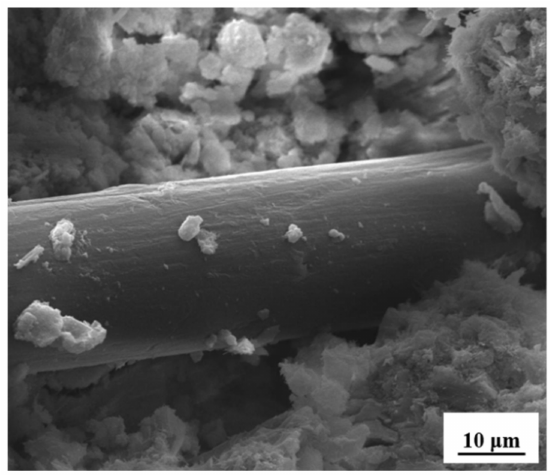
Figure 10. Treated PP fibers are pulled out of